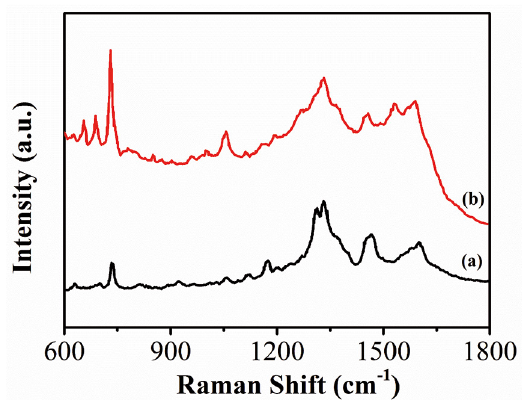
Figure 8: SERS spectra of 10 ─4 M adenine on (a) RGO-Ag and (b) CA-RGO-Ag-5